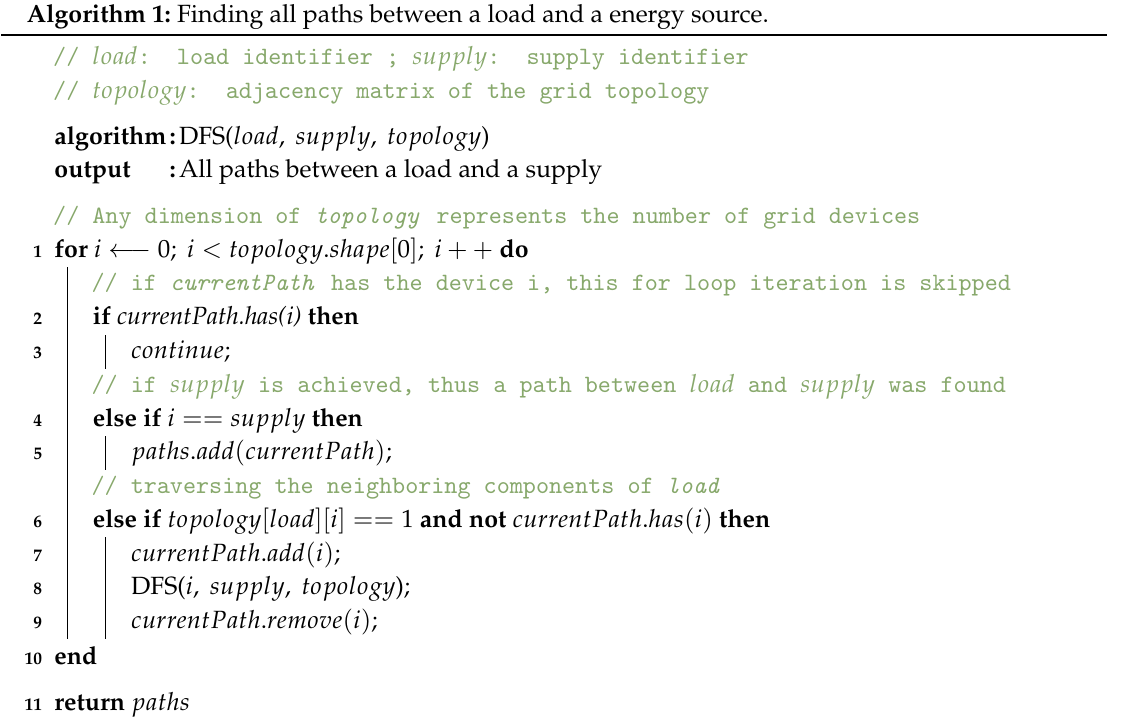
Algorithm 1: Finding all paths between a load and a energy source.